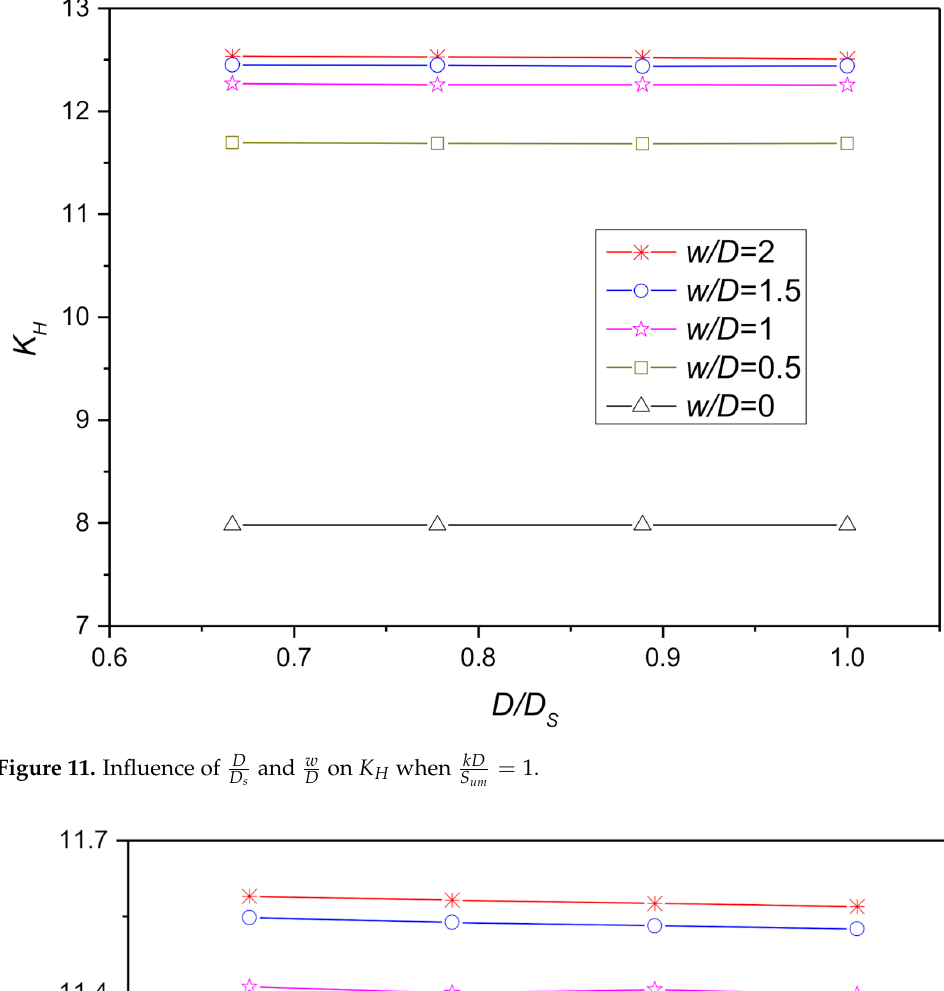
and w on K H when kD D s D